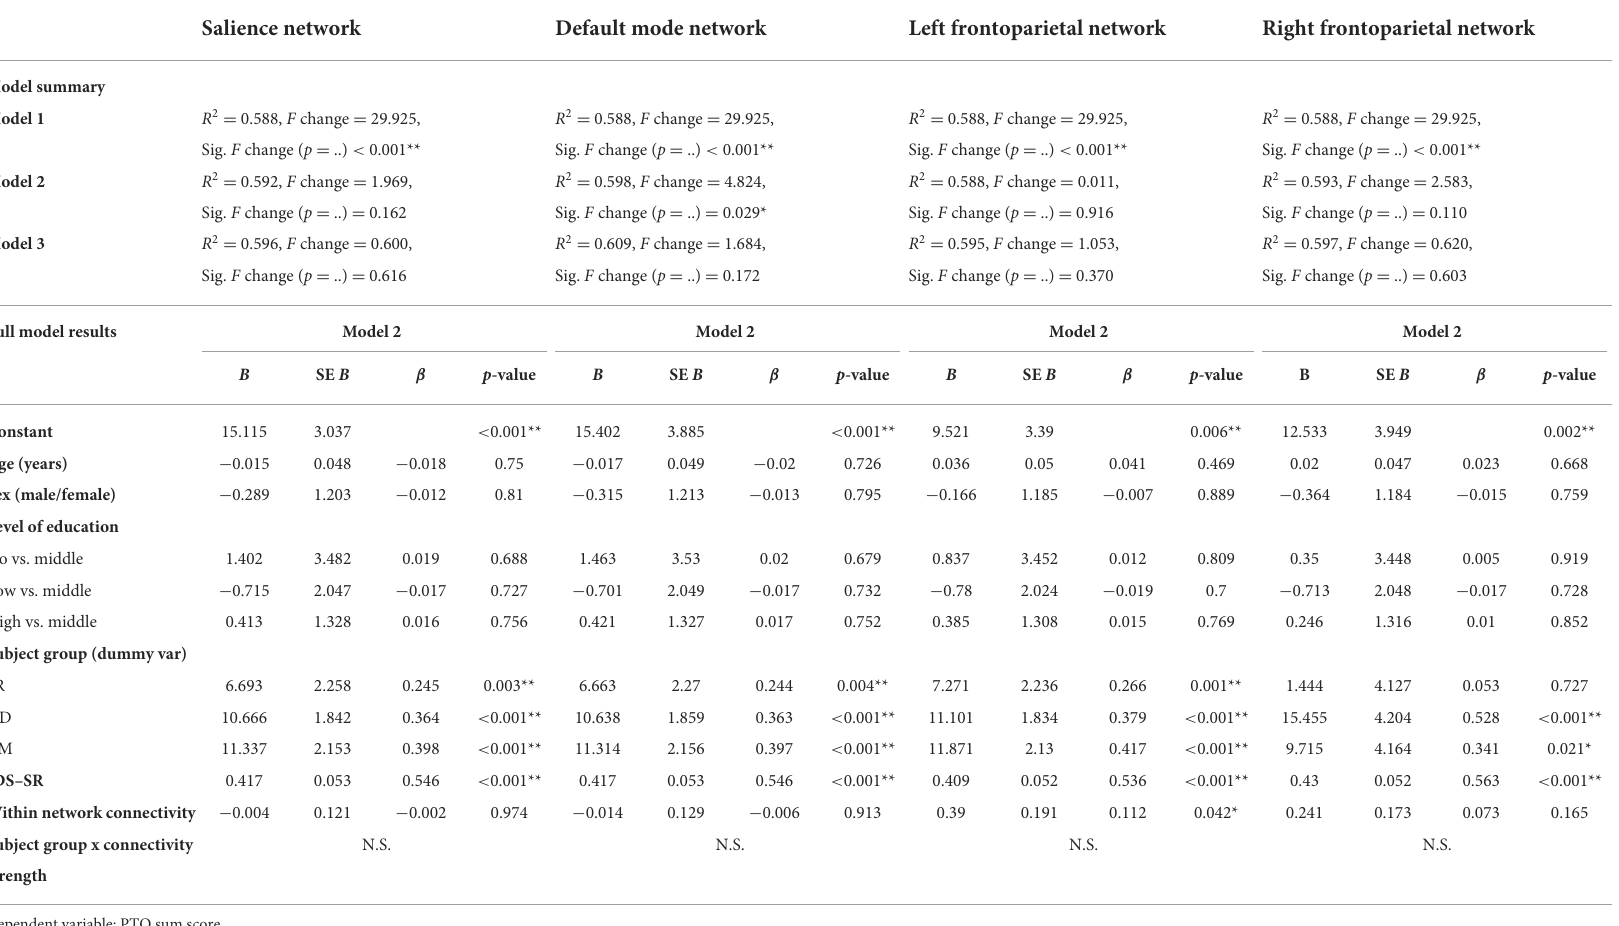
TABLE 3 Regression models: relationship between repetitive negative thinking (RNT) and stress induced changes in network connectivity